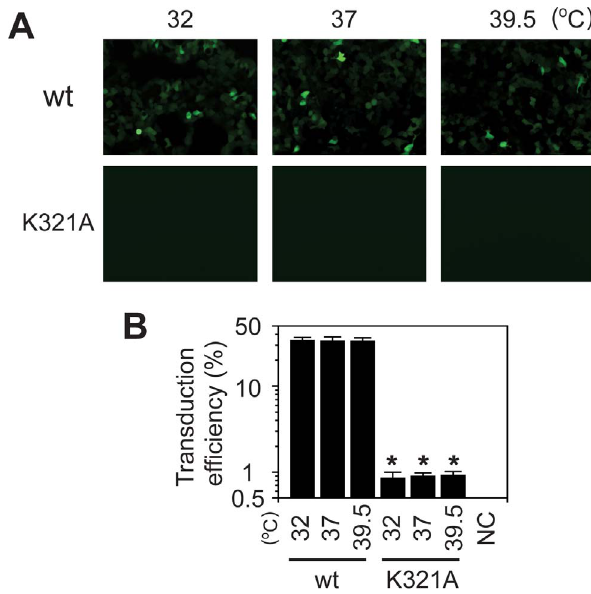
Figure 8. HEK293 cell transduction with wild type AAV2 or AAV2 K321A mutant expressing GFP. HEK293 cells were infected with double-stranded (ds) AAV2-CMV-GFP at MOI of 20,000 and maintained at 32, 37 or 39.5 u C. Forty-eight hours post-infection, cells were observed under a fluorescent microscope (Panel A) and subjected to flow cytometry (Panel B). The experiment was done in quadruplicate. Asterisks indicate statistical significance with P =0.000054 to 0.00032 (Student’s t-test) compared to the values of the corresponding wild type controls. Non-transduced cells were used as a negative control